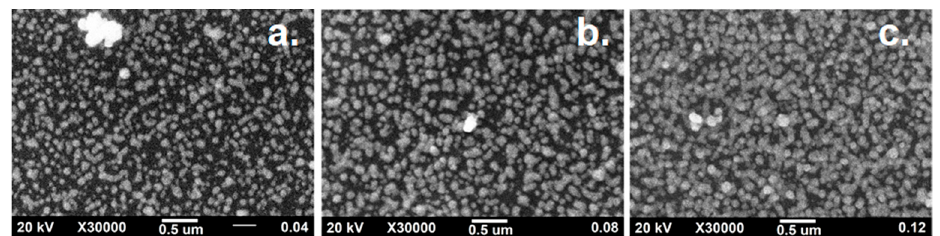
Figure 7. Scanning electron microscopy (SEM) images of the polyetheretherketone coated with one layer of silver nanoparticles in concentrations of ( a ) 0.04 mol/L, ( b ) 0.08 mol/L and ( c ) 0.12 mol/L.